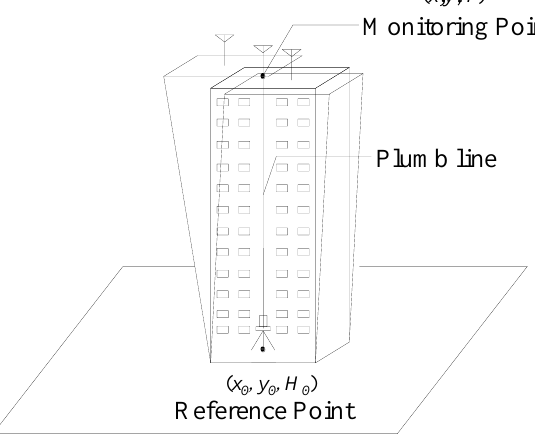
Figure 1. Schematic of plumbing with a laser plummet.